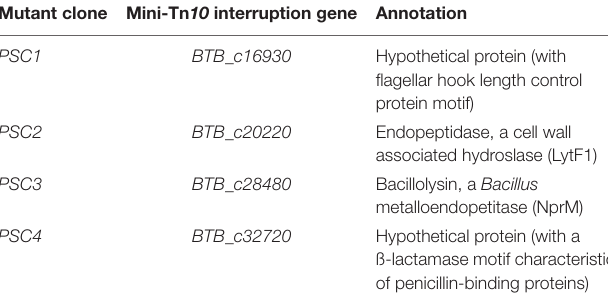
TABLE 1 | Loci of mini-Tn 10 insertions in the selected polymyxin B sensitive